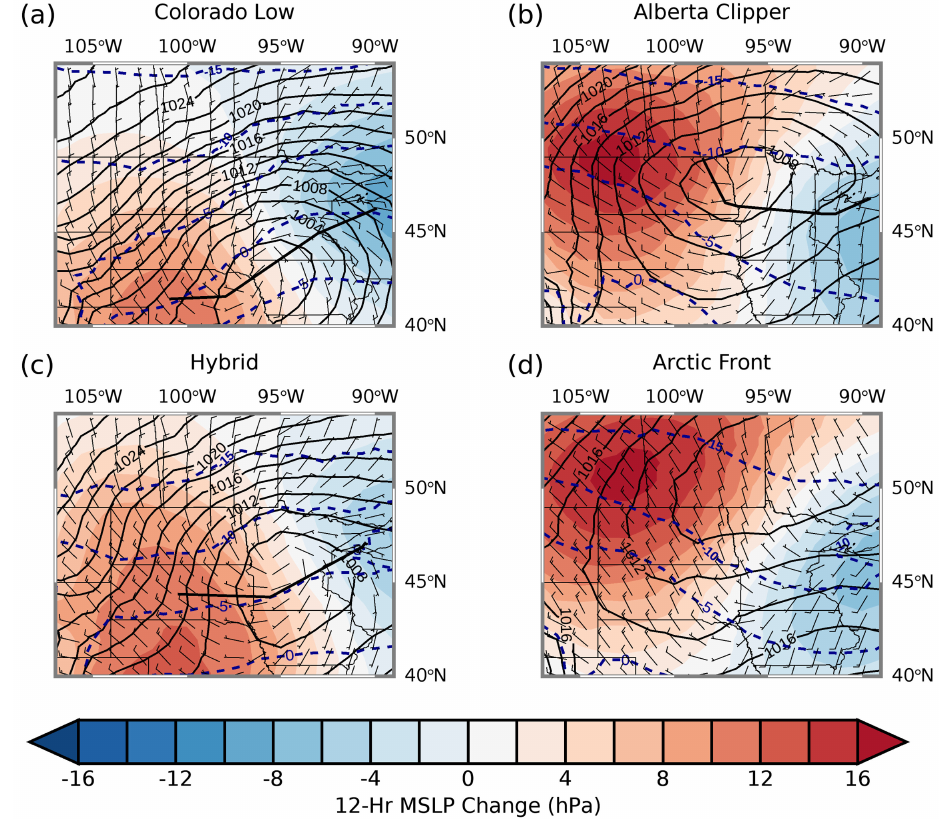
Figure 4. North American Regional Re-analysis (NARR) composite plots of mean sea level pressure (MSLP) (hPa), surface wind barbs (kts), and surface temperatures ( ◦ C) 12 hr prior to the midpoint of ( a ) Colorado Low, ( b ) Alberta Clipper, ( c ) Hybrid, and ( d ) Arctic Front blizzards. 12-h MSLP change (midpoint—12 hr prior) is provided by shaded contours while composite mean cyclone tracks are denoted by the thick black lines for select